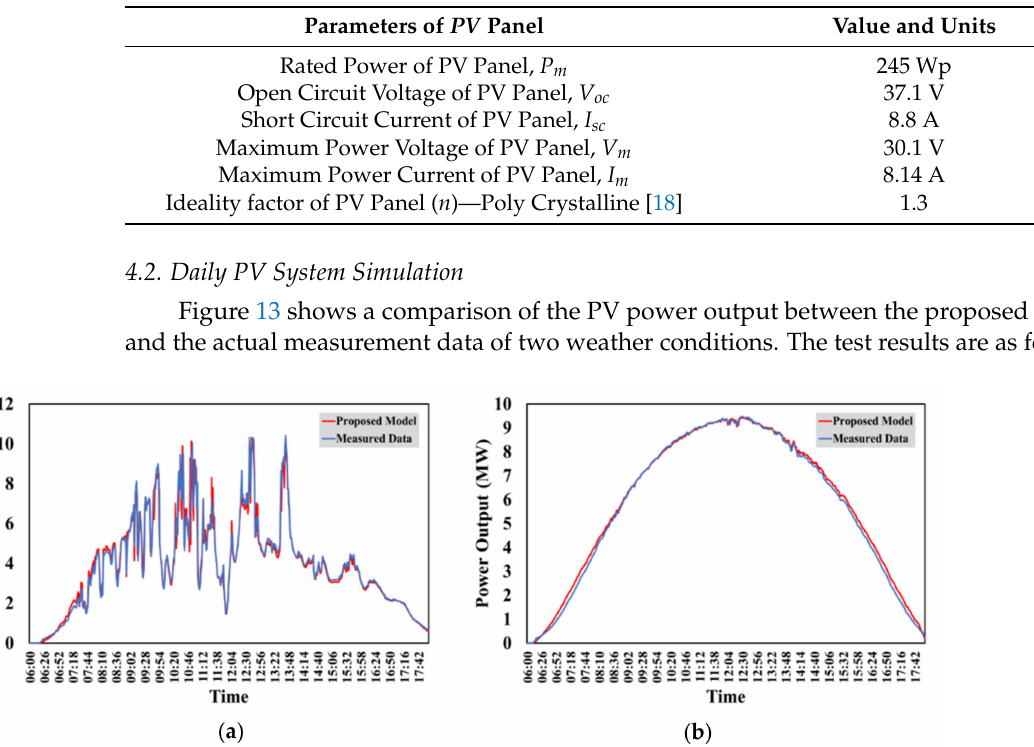
Table 6. Information of the PV panel for the experiment.